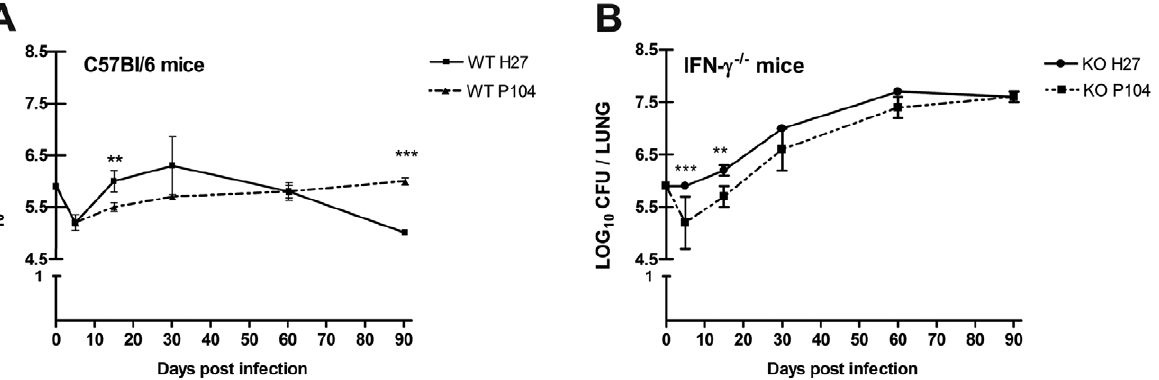
Figure 2. Lung bacillary loads in C57BL/6 WT and GKO mice infected with M.avium strains. Mice were infected by an i.t. injection of two M. avium strains, H27 and P104, isolated from different hosts (2.5 6 10 6 bacilli). At the indicated time-points, six mice were sacrificed, and bacterial burdens (CFU) in the lungs were measured. The data were obtained in three independent experiments. Asterisks represent statistical significance (**p , 0.01, ***p ,